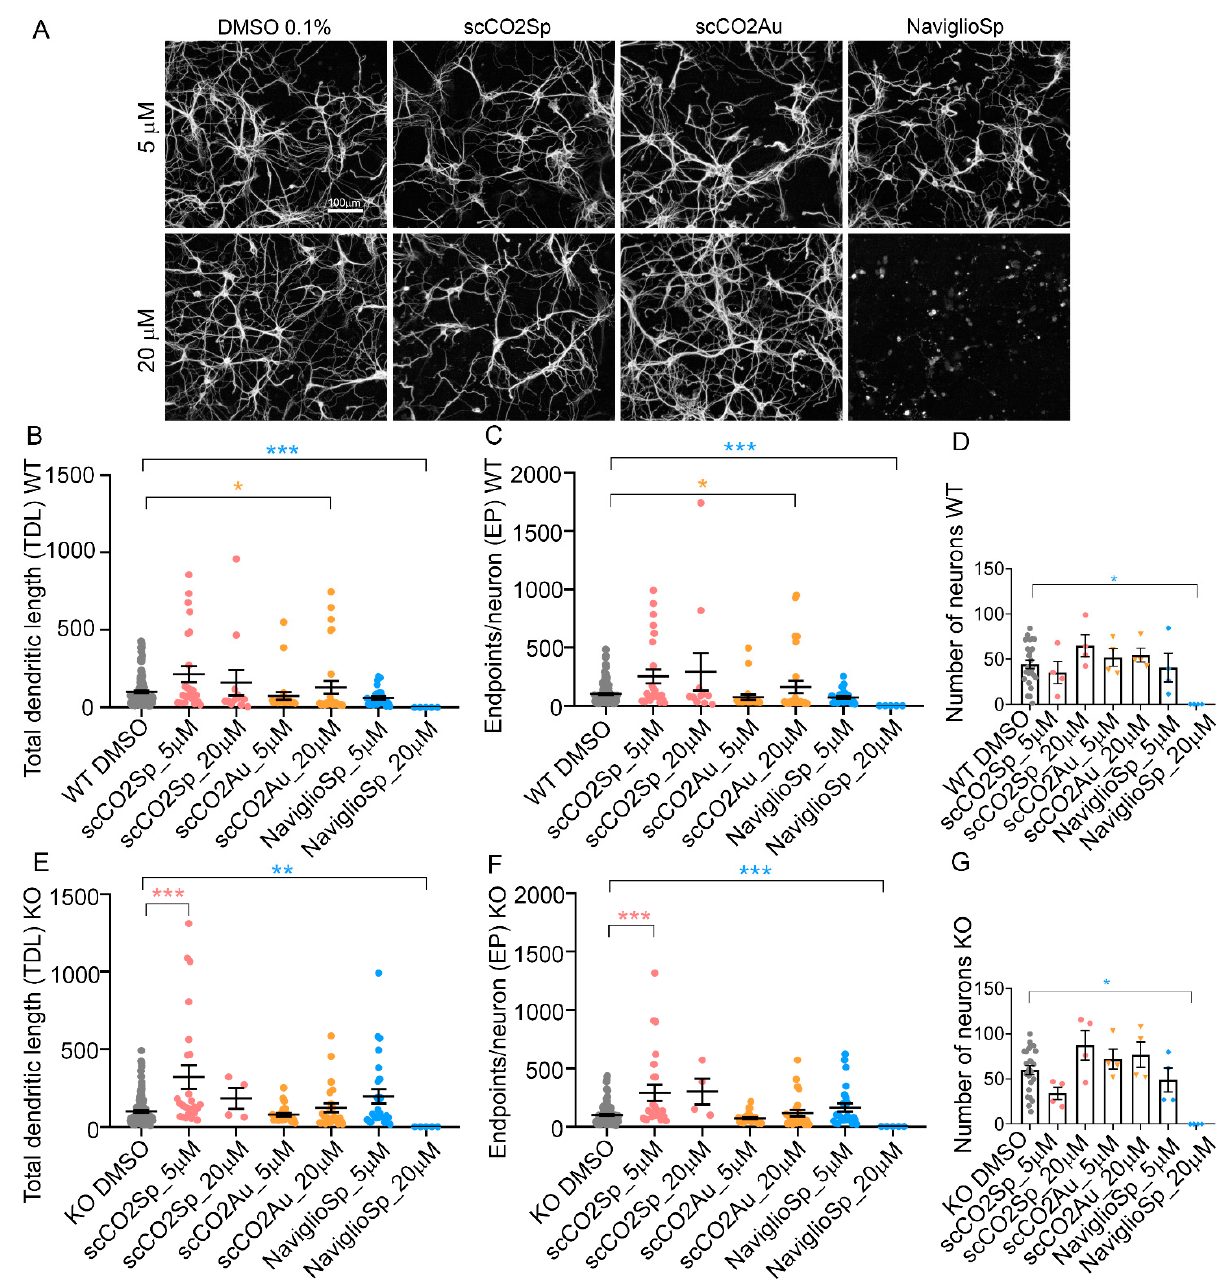
Figure 5. Treatments of neuronal cultures with cardoon extracts. ( A ) NeuriteQuant morphological analysis of TDL and Endpoints of DIV 6 hippocampal WT neurons, plated at the density of 160 cells mm − 2 ( n = 2). From left, WT neurons treated with DMSO 0.1% (control condition), scCO 2 Sp extract, scCO 2 Au extract, NaviglioSp extract. First line represents neurons treated at the concentration of 5 µ M (in DMSO 0.1%), second line at 20 µ M (in DMSO 0.1%). Scale bar: 100 µ m. ( B , C ) Quantitative data of WT neurons, reporting the average TDL per neuron ( µ m) and the average number of endpoints per neuron. n = 22 images for a total of 2 independent biological replicates (cell cultures). ( D ) Number of WT neurons per each condition. ( E , F ) Quantitative data of MeCP2 KO neurons, reporting the average TDL per neuron ( µ m) and the average number of endpoints per neuron. n = 22 images for a total of 2 independent biological replicates (cell cultures). ( G ) Number of MeCP2 KO neurons per each condition. Kruskal–Wallis with Dunnett’s multiple comparisons test vs. DMSO conditions. *** p < 0.001, ** p < 0.01, * p <